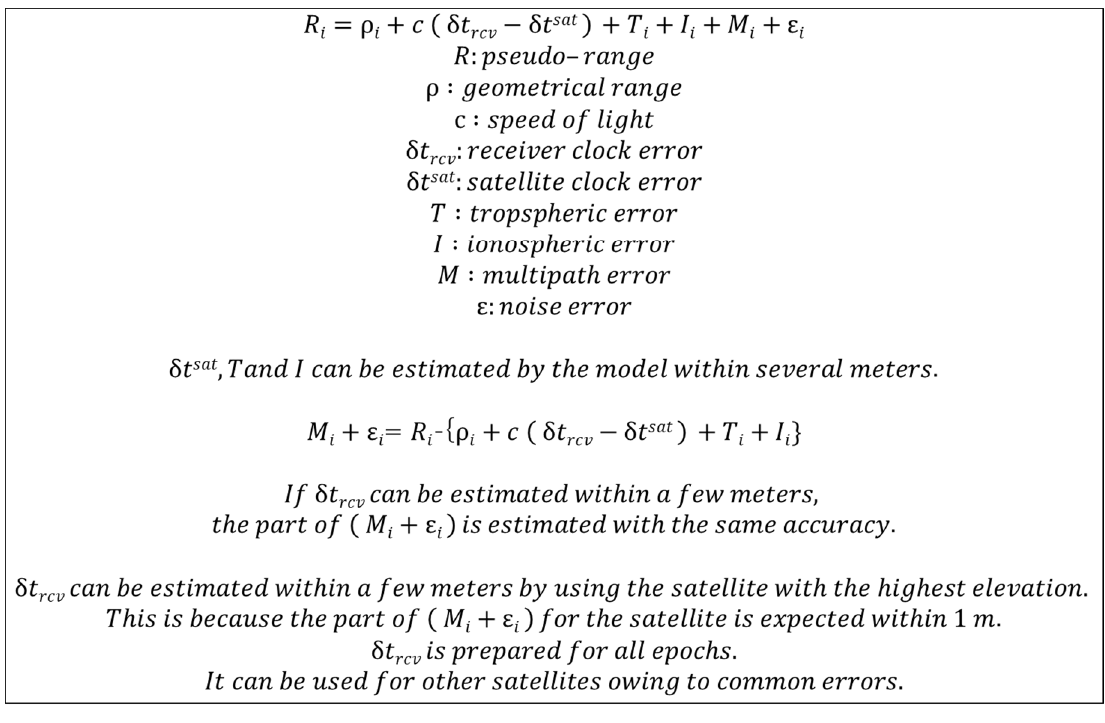
Figure 6. Summary and flow of pseudo-range error estimation.